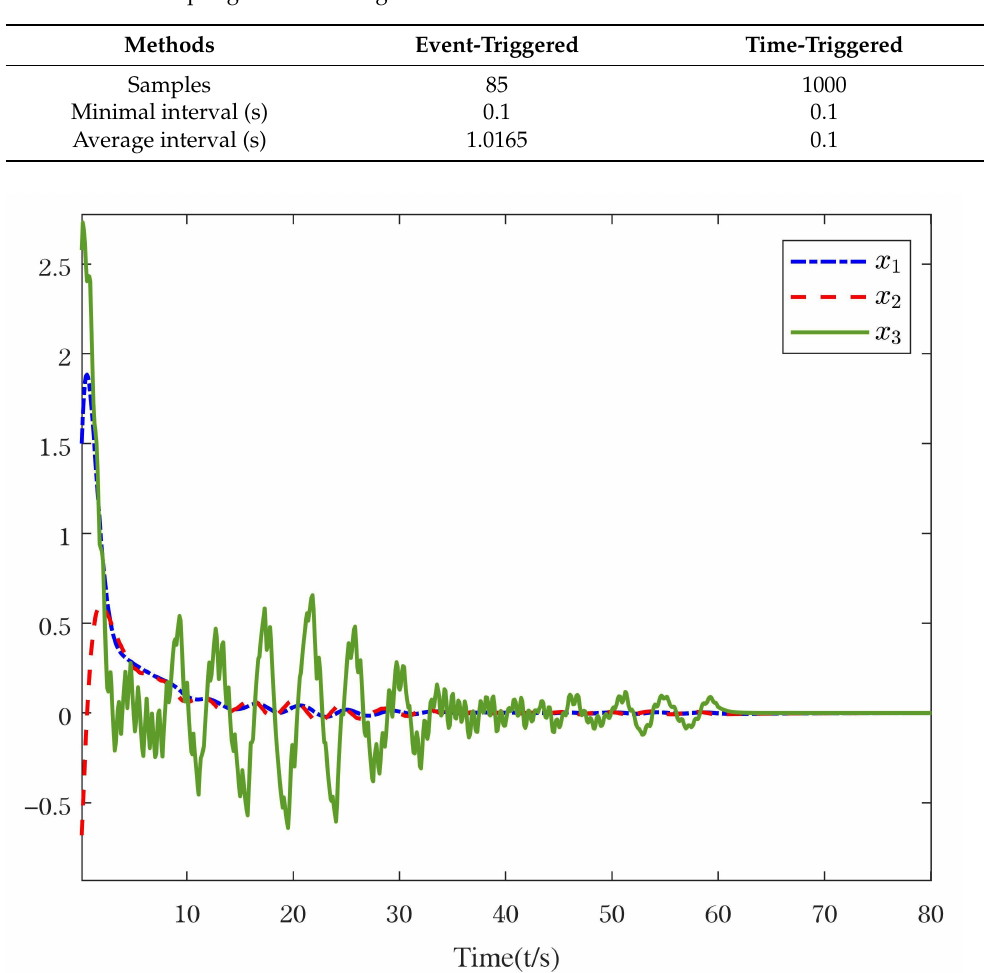
Figure 2. Three state vectors of linear